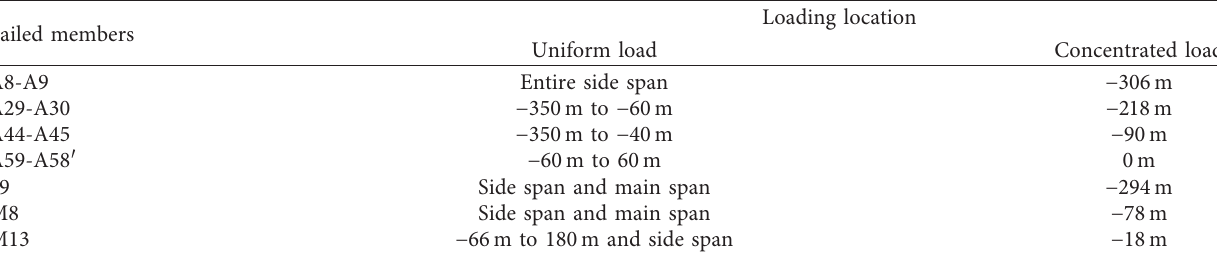
Figure 12: Loading location for the loading scenarios. Table 4: Load types and placement for different loading